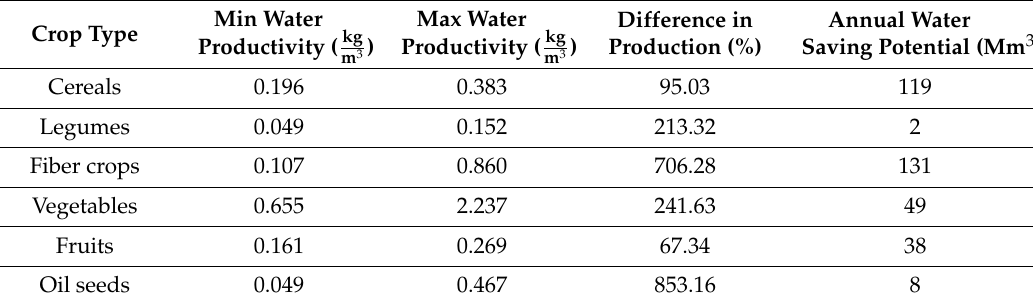
Table 4. Difference in water productivity and the water saving potential.